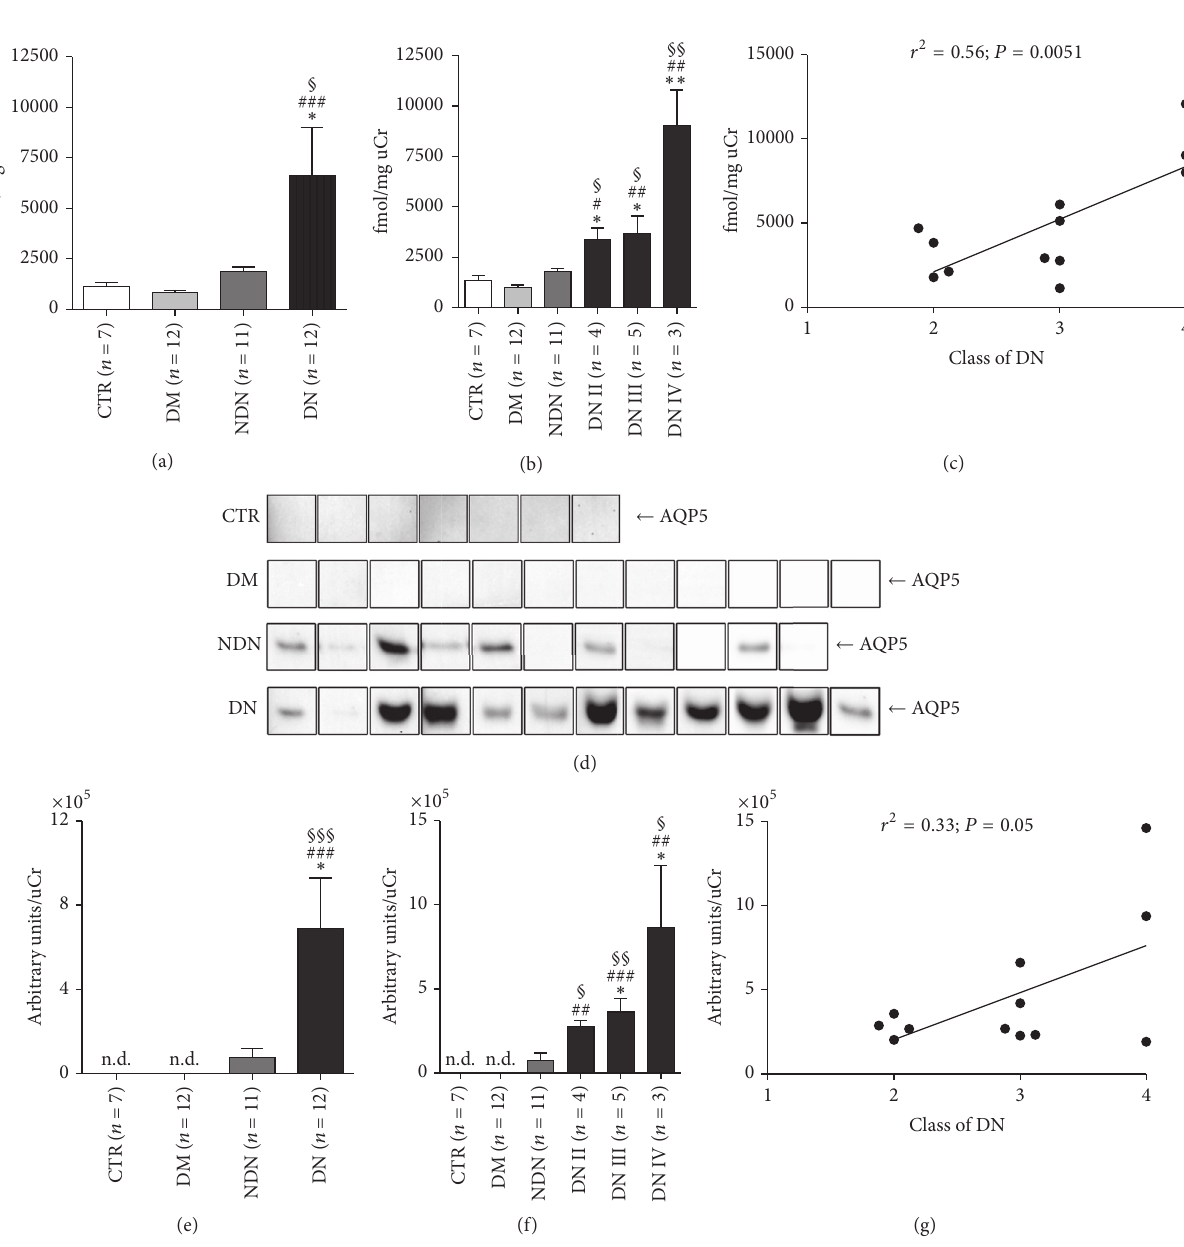
Figure 1: The urinary excretion of AQP5 dramatically increases in DN patients and positively correlates with the clinical severity of DN. (a) Urinary AQP5 excretion was measured by ELISA in urine samples of healthy subjects (CTR, 𝑛 = 7 ), patients with DM ( 𝑛 = 12 ), patients with NDN ( 𝑛 = 11 ), and patients with DN ( 𝑛 = 12 ) and expressed as fmol/mg urine creatinine. All data are reported as mean ± SEM. § 𝑃 < 0.05 versus CTR, ### 𝑃 < 0.001 versus DM, and ∗ 𝑃 < 0.05 versus NDN, obtained by Kruskal-Wallis one-way ANOVA test. (b) DN patients were grouped according to the histological changes evaluated by kidney biopsy: DN stage II ( 𝑛 = 4 ), DN stage III ( 𝑛 = 5 ), and DN stage IV ( 𝑛 = 3 ) and uAQP5 at each stage compared to uAQP5 in CTR and DM and NDN patients. All data are reported as mean ± SEM. §§ 𝑃 < 0.01 and § 𝑃 < 0.05 versus CTR, ## 𝑃 < 0.01 and # 𝑃 < 0.05 versus DM, and ∗∗ 𝑃 < 0.01 and ∗ 𝑃 < 0.05 versus NDN, obtained by Kruskal-Wallis one-way ANOVA test. (c) Linear regression analysis of uAQP5 abundance, as measured by ELISA, with the class of DN ( 𝑟 2 = 0.56 ; 𝑃 = 0.0051 ). (d) Exosomes were isolated from urine of healthy subjects (CTR, 𝑛 = 7 ), patients with DM ( 𝑛 = 12 ), patients with NDN ( 𝑛 = 11 ), and patients with DN ( 𝑛 = 12 ) using the two-step differential centrifugation method. Total exosome proteins were resolved on 12% SDS-PAGE and analyzed by Western blotting for AQP5 abundance. (e) Densitometry analysis of the uAQP5 band intensities was normalized for uCr and reported as means ± SEM. §§§ 𝑃 < 0.001 versus CTR, ### 𝑃 < 0.001 versus DM, and ∗ 𝑃 < 0.05 versus NDN, obtained by Kruskal-Wallis one-way ANOVA test. n.d.: nondetectable. (f) DN patients were grouped according to the histological changes evaluated by kidney biopsy: DN stage II ( 𝑛 = 4 ), DN stage III ( 𝑛 = 5 ), and DN stage IV ( 𝑛 = 3 ) and densitometry analysis of uAQP5 at each stage compared to uAQP5 in CTR and DM and NDN patients. All data are reported as mean ± SEM. §§ 𝑃 < 0.01 and § 𝑃 < 0.05 versus CTR, ## 𝑃 < 0.01 and ### 𝑃 < 0.001 versus DM, and ∗ 𝑃 < 0.05 versus NDN, obtained by Kruskal-Wallis one-way ANOVA test. (g) Linear regression analysis of uAQP5 abundance, as semiquantified by Western blotting, with the class of DN ( 𝑟 2 = 0.33 ; 𝑃 = 0.05